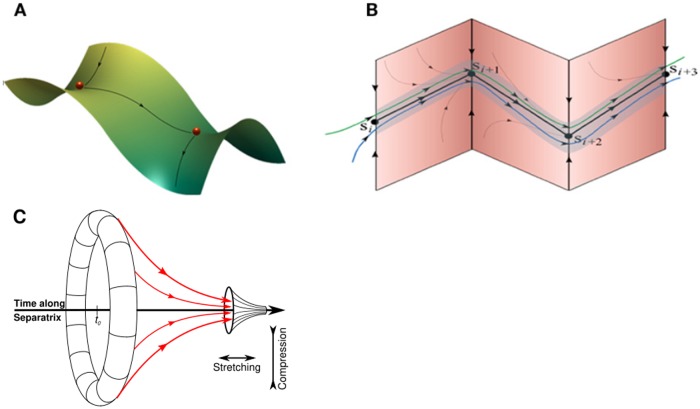
(A) Stable heteroclinic chain with two connected metastable states (B) Stable heteroclinic channel (SHC)—robust sequence of metastable states. Adapted from [82]. (C) Transformation of the phase volume along trajectories in the neighborhood of unstable separatrix in the case when both coupled saddles are characterized by saddle values larger than one.